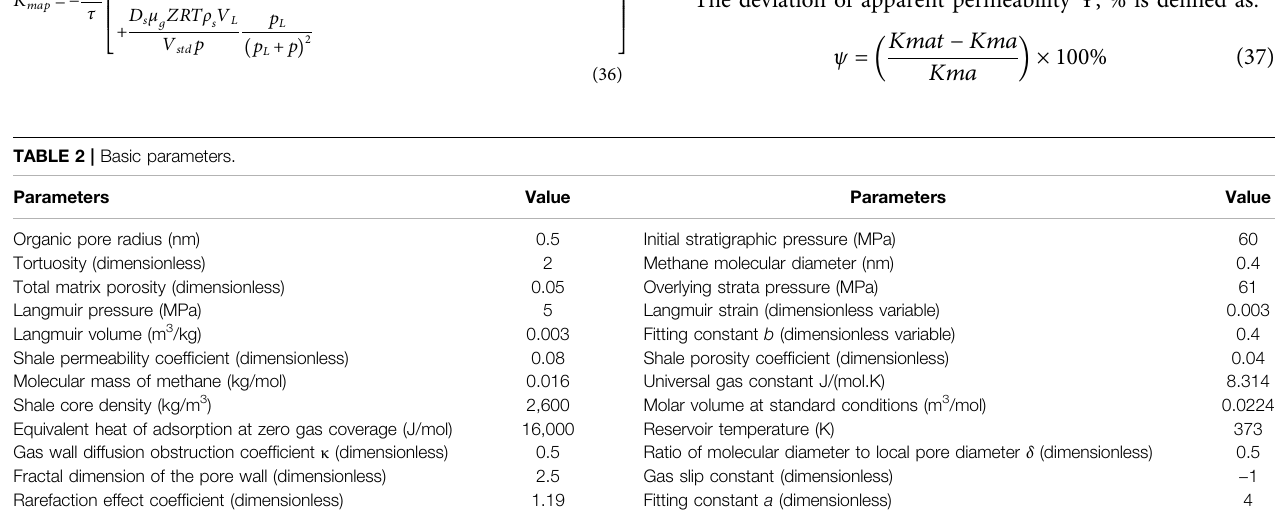
TABLE 2 | Basic parameters. Parameters Value Organic pore radius